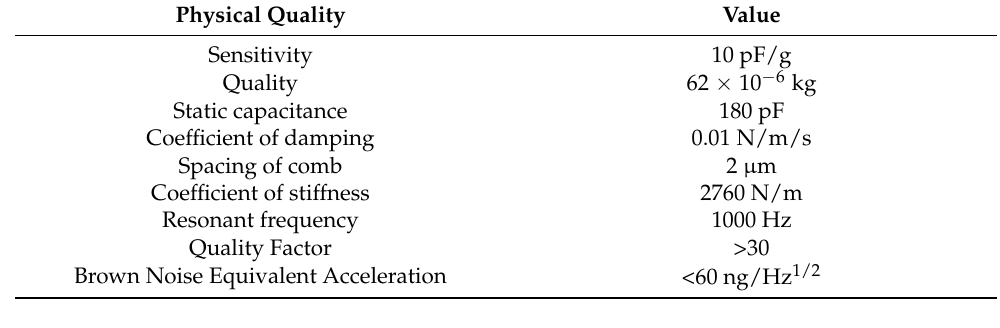
Table 1. Properties summary and comparison.